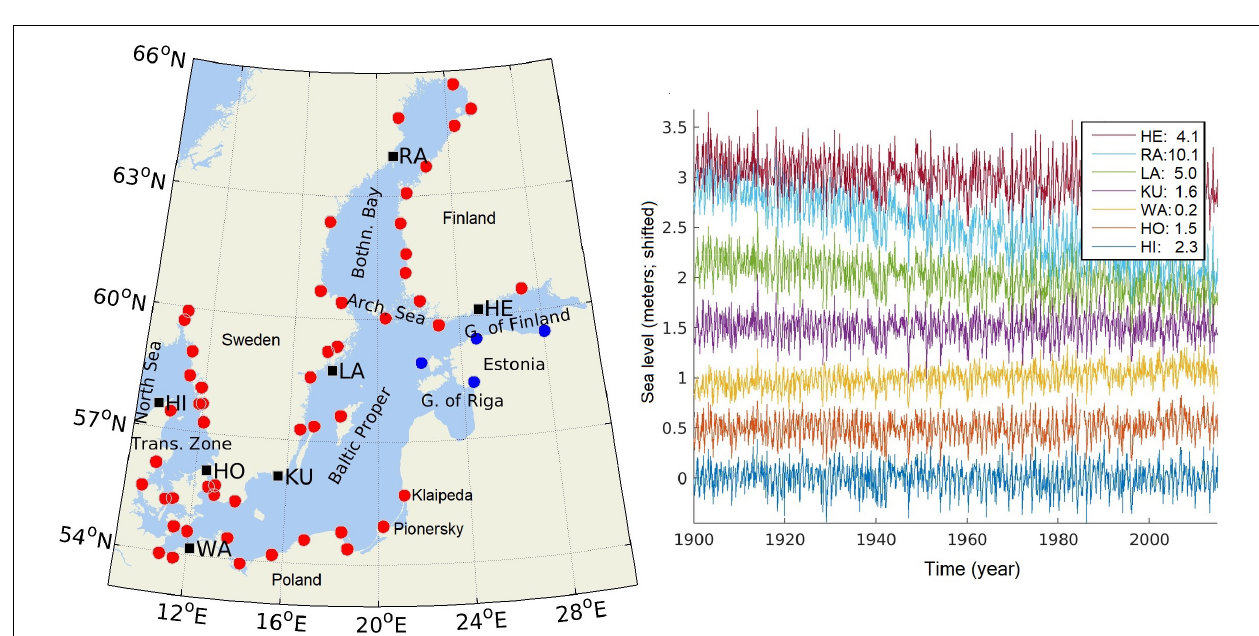
FIGURE 2 | Left: Study area and sea level stations used in the present study (red and black: PSMSL stations, blue: Estonian stations). The seven tide gauge records used for the sea level reconstruction (TGin, black squares) are: Helsinki (HE), Ratan (RA), Landsort (LA), Kungsholmsfort (KU), Warnemünde (WA), Hornbæk (HO), and Hirtshals (HI). All other stations were used for validation (TGval, red and blue circles). Right: Time series of monthly sea level (meters, zero-point shifted for each station) for TGin (1900–2014), showing the influence of land uplift. The value after the station code represents geocentric uplift rate at the location (Vestøl et al., 2019).